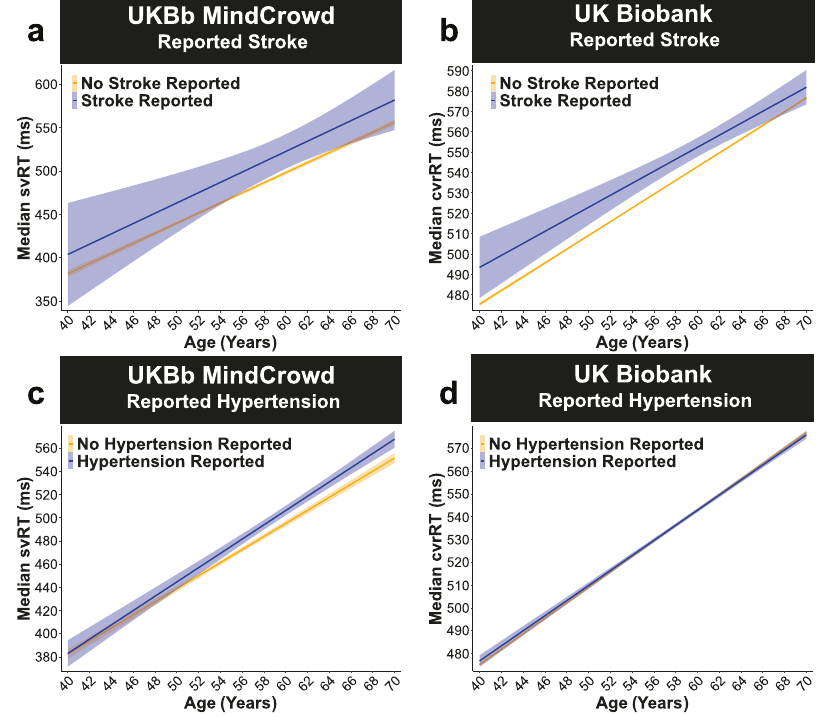
Fig. 6 UK Biobank: reported stroke and hypertension. UKBb MindCrowd and UK Biobank analysis (ages 40 – 70) of visual reaction time (RT). a – b Reported Stroke was associated with lengthened visual reaction time (RT). a UKBb MindCrowd linear model fi ts (line fi ll ±95% CI) of median simple visual RT (svRT) from young to old Age with lines split by Reported Stroke. b UK Biobank linear model fi ts (line fi ll ±95% CI) of median complex visual recognition RT (cvrRT) from young to old Age with lines split by Reported Stroke. In both the UKBb MindCrowd svRT ( β Stroke = 18.47, p Stroke = 4.00E − 02, Reported Stroke n = 2807, No Reported Stroke n = 39,318) and UK Biobank cvrRT ( β Stroke = 10.61, p Stroke = 6.15E − 07, Reported Stroke n = 1237, No Reported Stroke n = 157,008) analysis, experiencing a Reported Stroke was associated with lengthened visual RT. c – d Reported Hypertension was associated with lengthened visual RT. c UKBb MindCrowd linear model fi ts (line fi ll ±95% CI) of median svRT from young to old Age with lines split by Reported Hypertension. d UK Biobank linear model fi ts (line fi ll ±95% CI) of median cvrRT from young to old Age with lines split by Reported Hypertension. Unlike the MindCrowd analysis, hypertension was related to longer svRTs in UKBb MindCrowd ( β Hypertension = 7.99, p Hypertension = 3.16E − 03, Hypertension Reported n = 9676, No Hypertension Reported n = 30,119) and cvrRT in the UK Biobank ( β Hypertension = 1.14, p Hypertension = 0.02, Hypertension Reported n = 32,593, No Hypertension Reported n =